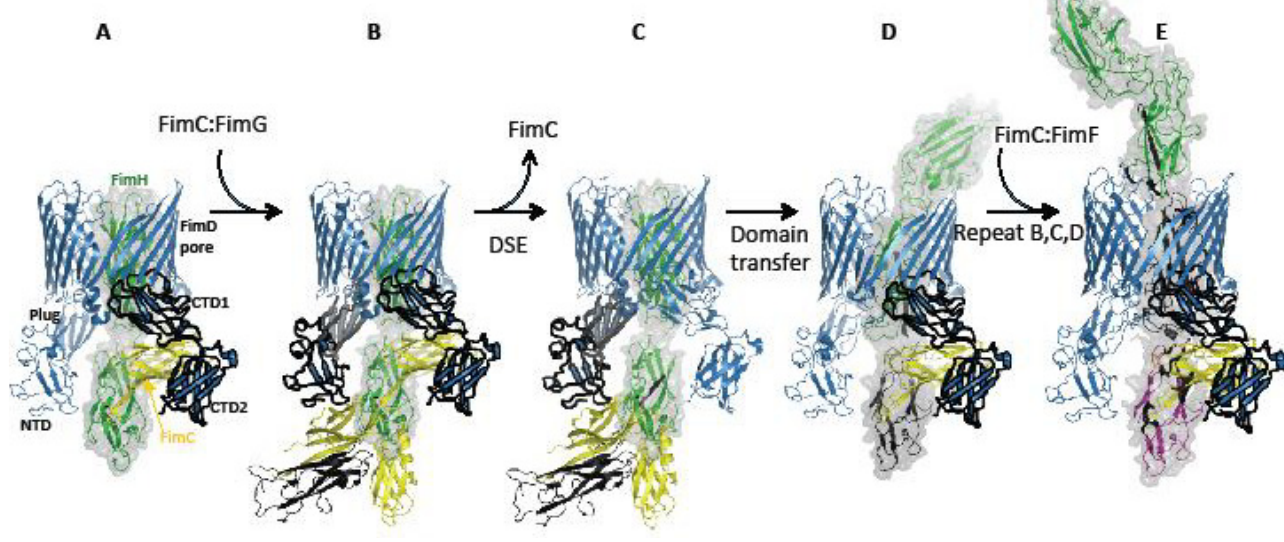
Figure 2. Formation of the type 1 tip complex: ( A ) The FimD:FimC:FimH complex (PDB 3RFZ). All usher domains are labelled, as well as FimC and FimH. ( B ) Modelled addition of FimC:FimG to FimD:FimC:FimH prior to DSE. FimC:FimG binds to the N-terminal domain (NTD) of FimD with its disordered Nte oriented towards the P5 pocket of FimH in preparation for donor-strand exchange (DSE) [25]. ( C ) FimG undergoes DSE with FimH, displacing FimC from the FimC:FimH complex and removing it from the FimD C-terminal domains (CTDs) in preparation for translocation. ( D ) FimC:FimG transfers to the CTDs. In doing so, FimH is translocated inside the FimD pore. ( E ) After a repeat of steps B, C and L D with FimF instead of FimG, the tip assembly complex is complete, with FimH fully translocated (PDB 4J3O) [59]. FimD is coloured in blue, FimC in yellow, FimH in green, FimG in black and FimF in magenta. Domains of FimD, which interact with the chaperone/subunits in any given step, are outlined in